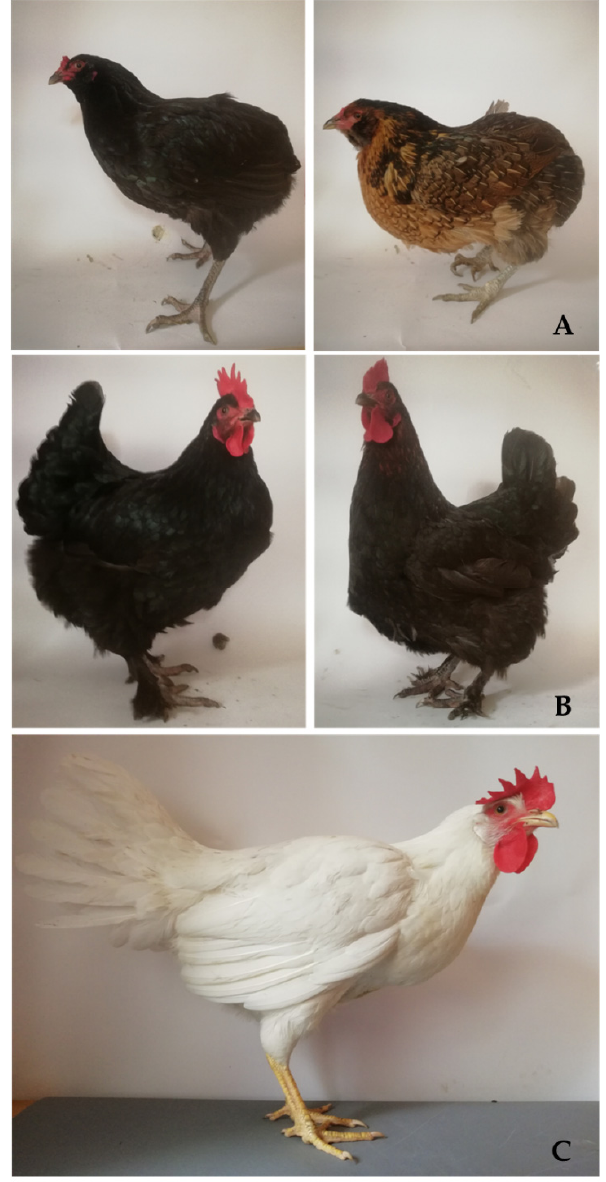
Figure 1. The exterior of particular breeds of hens included ij the study; A —Araucana, B —Marans, C —Lg—Leghorn.